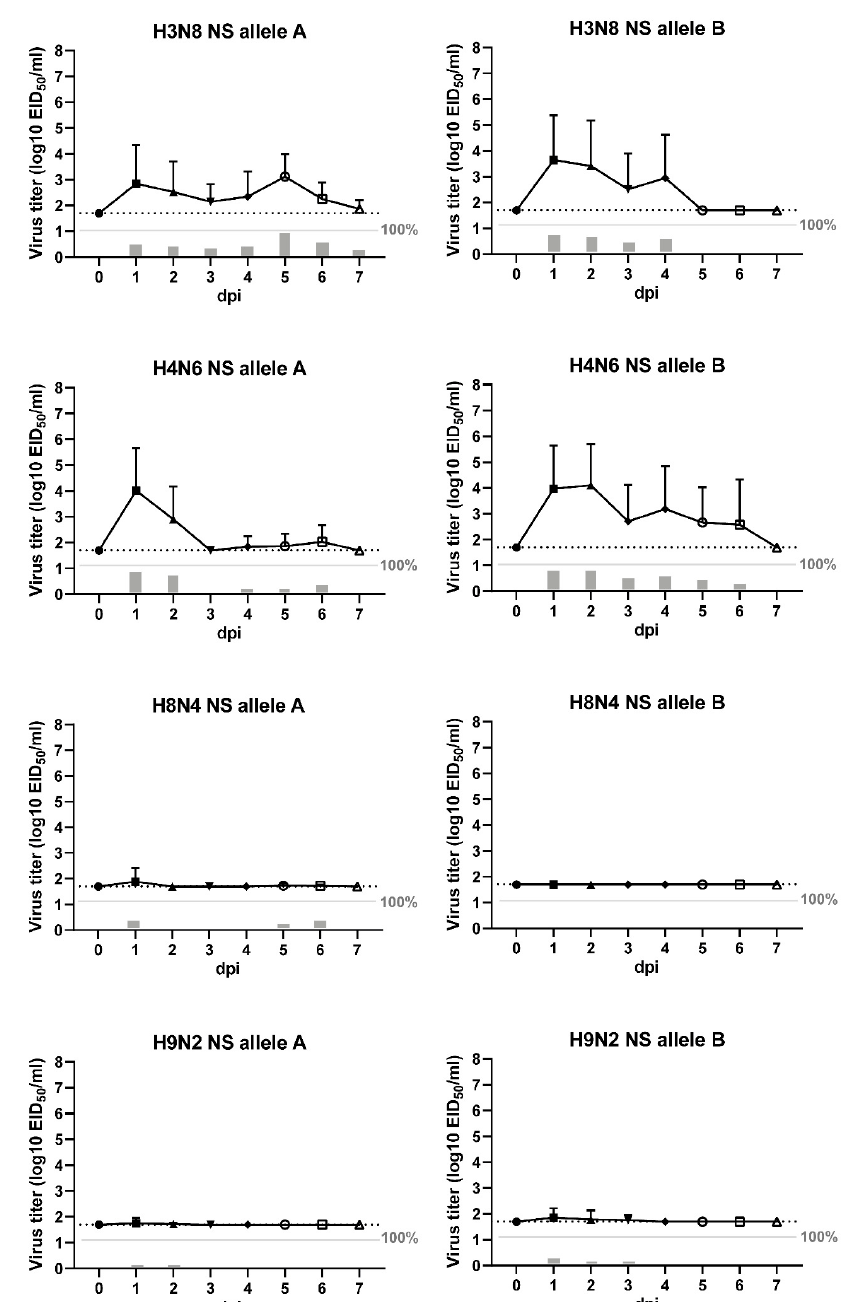
Figure 2. Oropharyngeal shedding. Virus detected in oropharyngeal (OP) swabs collected from chickens inoculated by the intranasal (IN) and intratracheal (IT) route with eight strains of low pathogenic avian influenza (LPAI) viruses (10 5.3 median egg infectious dose (EID 50 ) per bird). The swabs were taken daily from live birds to seven days post inoculation (dpi) for virus detection by influenza virus-specific PCR (M-PCR). Viral shedding is expressed as the mean equivalent log10 EID 50 / mL titre ± standard deviation (SD) with a lower detection limit of 10 1.7 EID 50 / mL (dashed line). The grey bars below the solid line indicate the percentage of positive swabs.